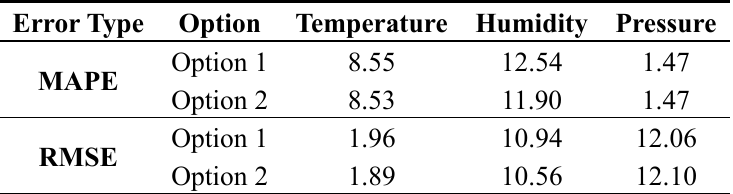
Table 4. Confirmatory experiment: error analysis summaries.